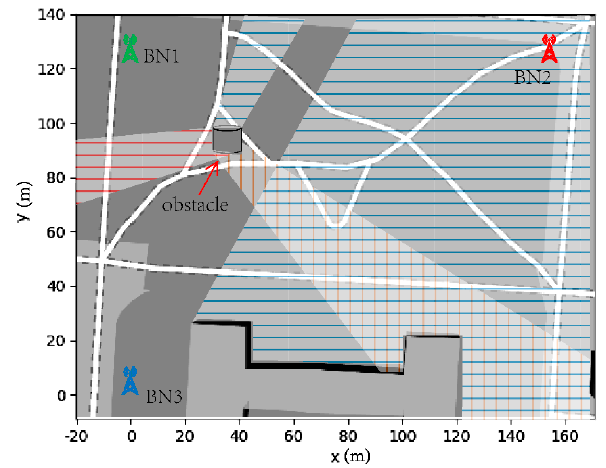
Figure 8. Deployment of BNs and UWB communication coverage situation.